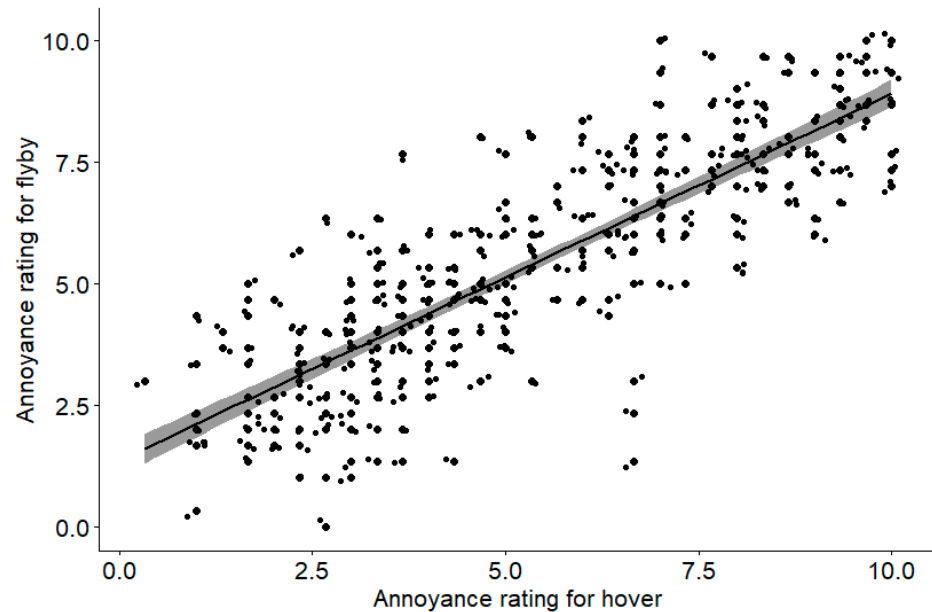
Figure 10. Correlation analysis between annoyance ratings in hover and flyby.